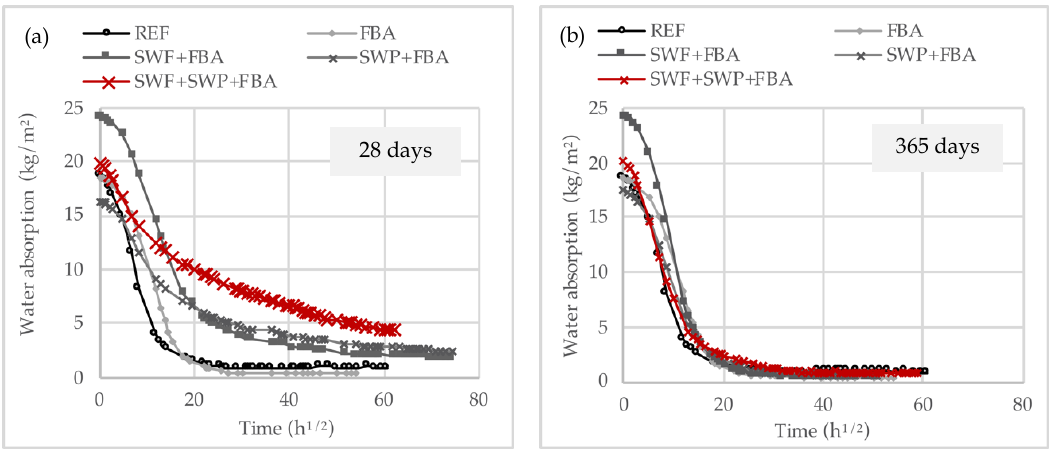
Figure 2. Drying curves (loss of water per square root of time) at 28 days ( a ) and 365 days ( b ).